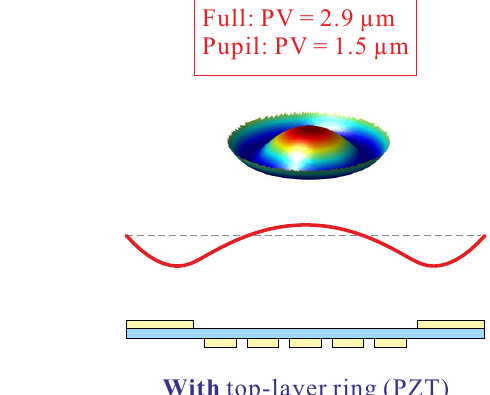
Figure 6. Thermal deformations induced in the mirror by ∆ T = 15 K; the substrate is SiC. Left: without PZT ring on the front side. Right: with PZT ring (200 µ m).